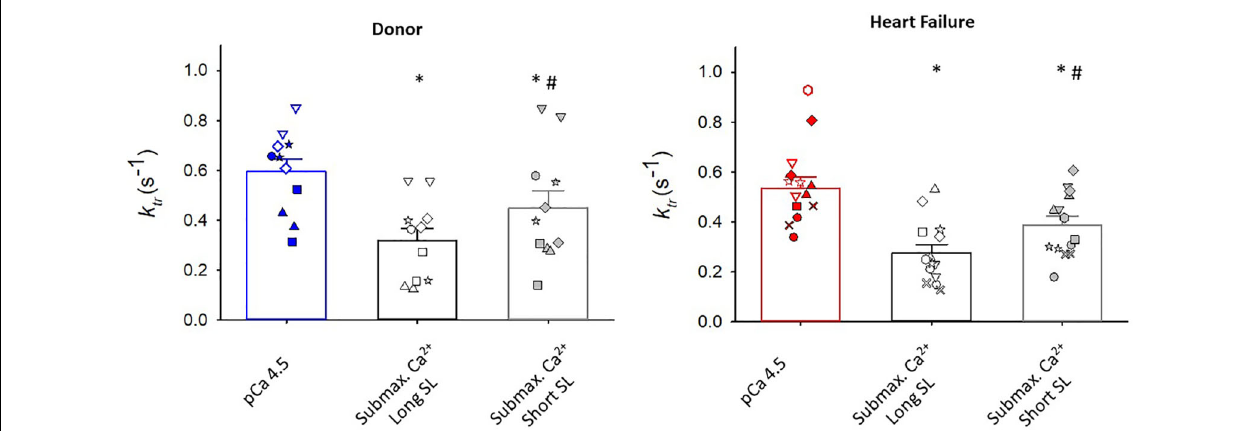
FIGURE 4 | Regulation of rate of force development ( k tr ). In myocytes from organ donors ( N = 6 hearts, n = 11 cardiac myocyte preparations) and patients with heart failure ( N = 8 hearts, n = 14 cardiac myocyte preparations), k tr values were lower during half maximal than maximal Ca 2 + activations (* p < 0.001). At half-maximal Ca 2 + activations, k tr values were lower at long sarcomere length ( # p < 0.001). Different symbols indicate data points from each heart sample. Linear mixed model testing for main effects of heart failure status, k tr experimental condition, and their statistical interaction.